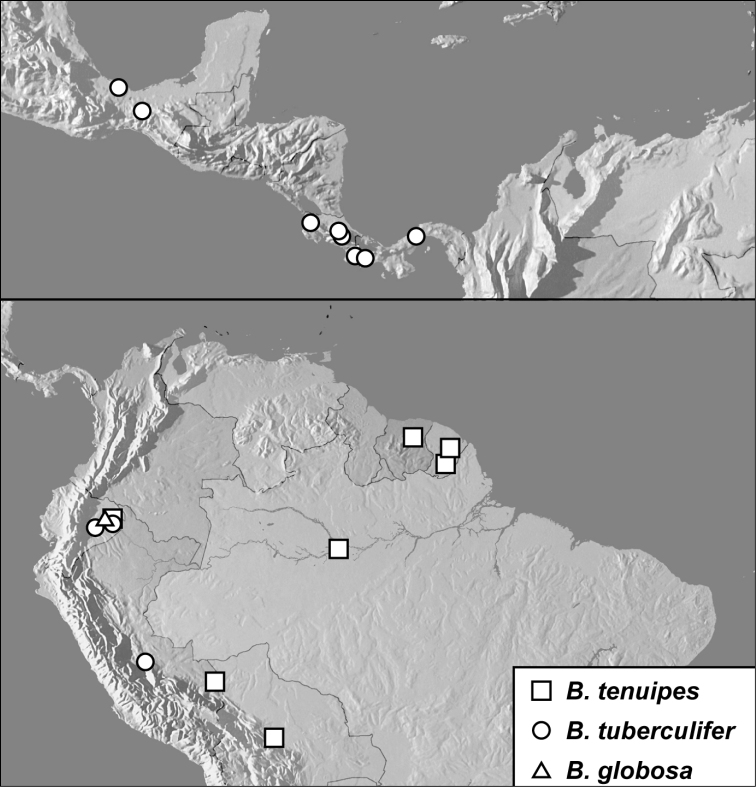
Baconia gibbifer group records.